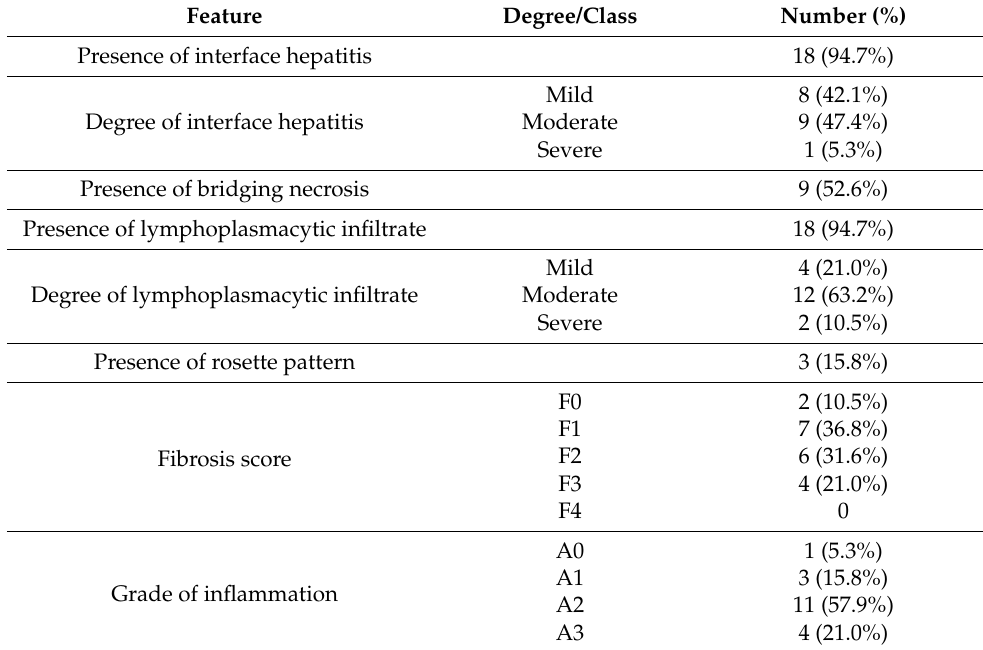
Table 2. Histopathologic characteristics of autoimmune hepatitis patients included in the